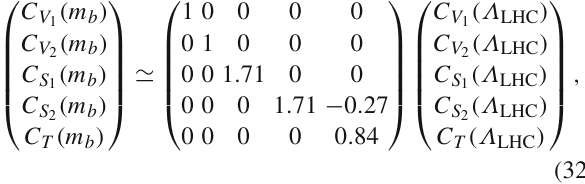
can- T = 0 . 19 already exceeds the T